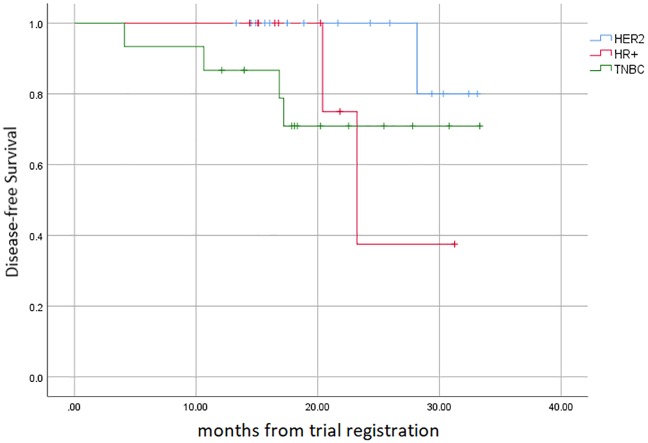
Kaplan-Meier estimates for DFS according to breast cancer subtype.